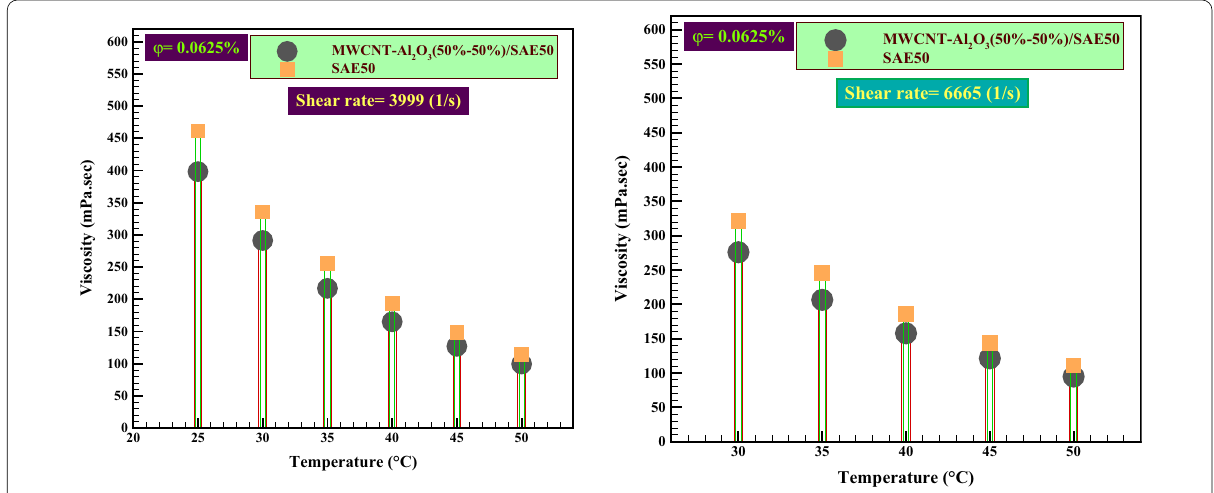
Fig. 9 Comparison of the effect of temperature on μ nf at φ